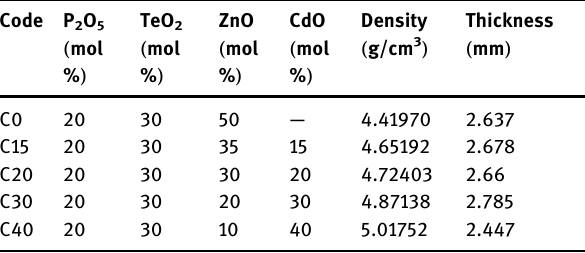
Table 1: Glass codes, glass compositions, thickness, and density values of